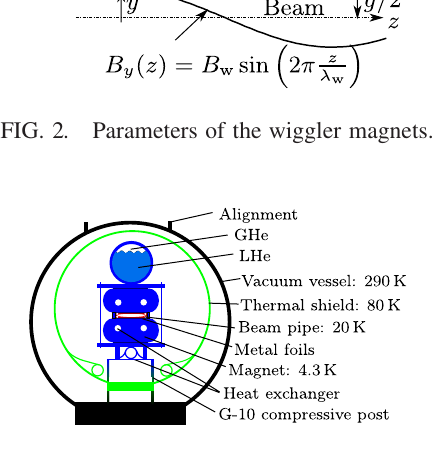
FIG. 3. Conceptual design of